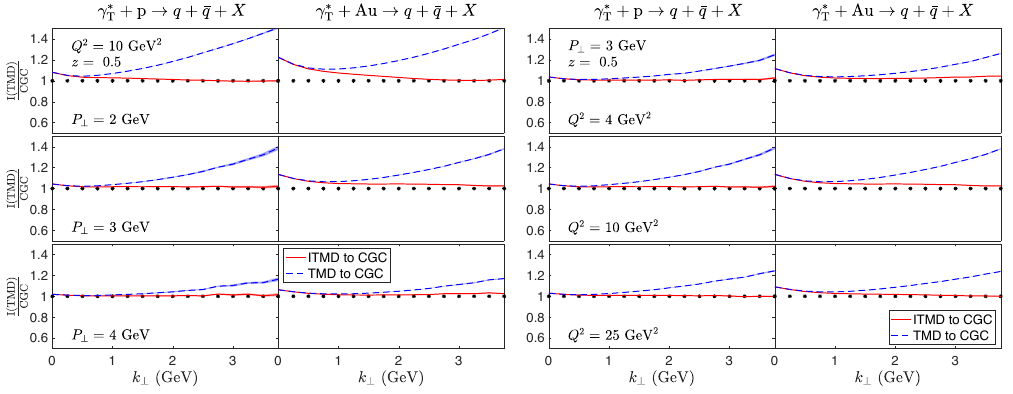
Figure 3 . Top: differential yield (averaged over azimuthal angles φ P of quark anti-quark pairs in γ ∗ differential yield in the (I)TMD to the CGC.